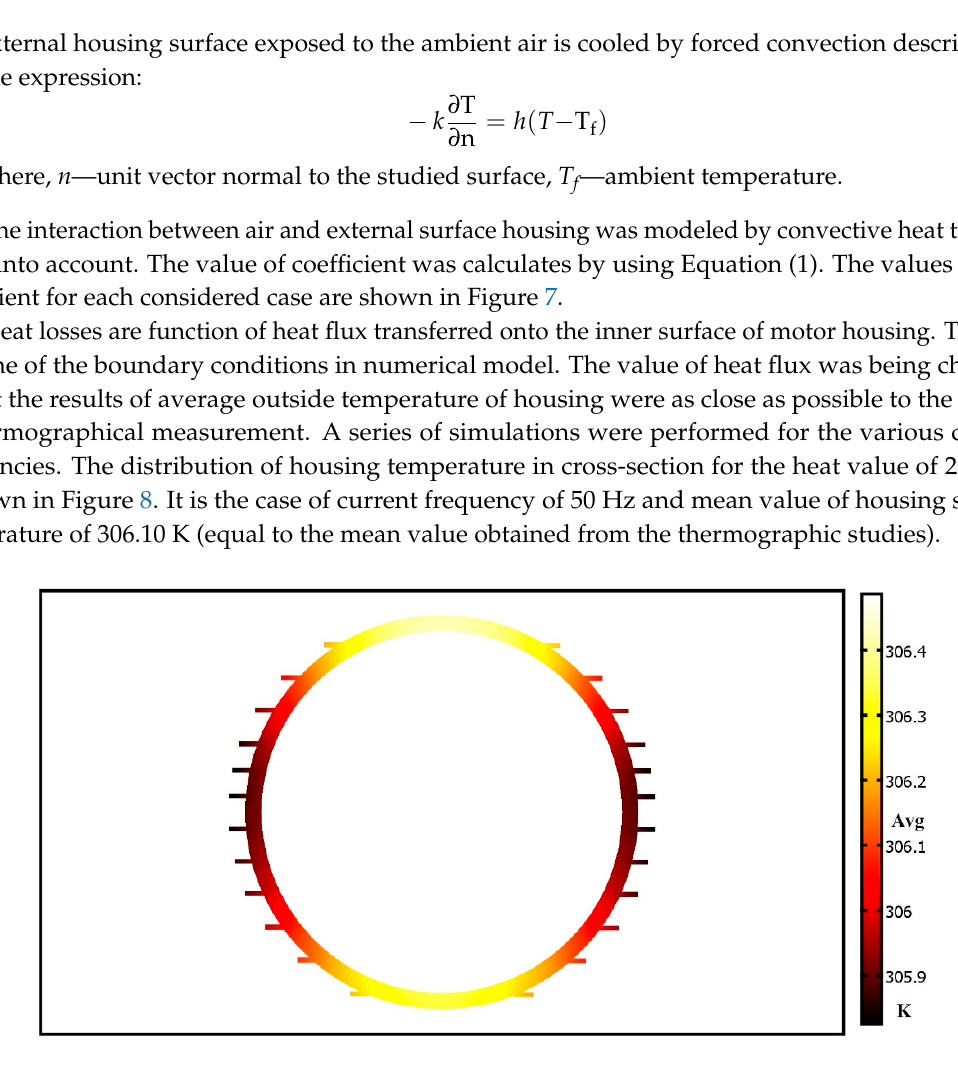
Figure 8. Temperature distribution in cross-section of the housing.